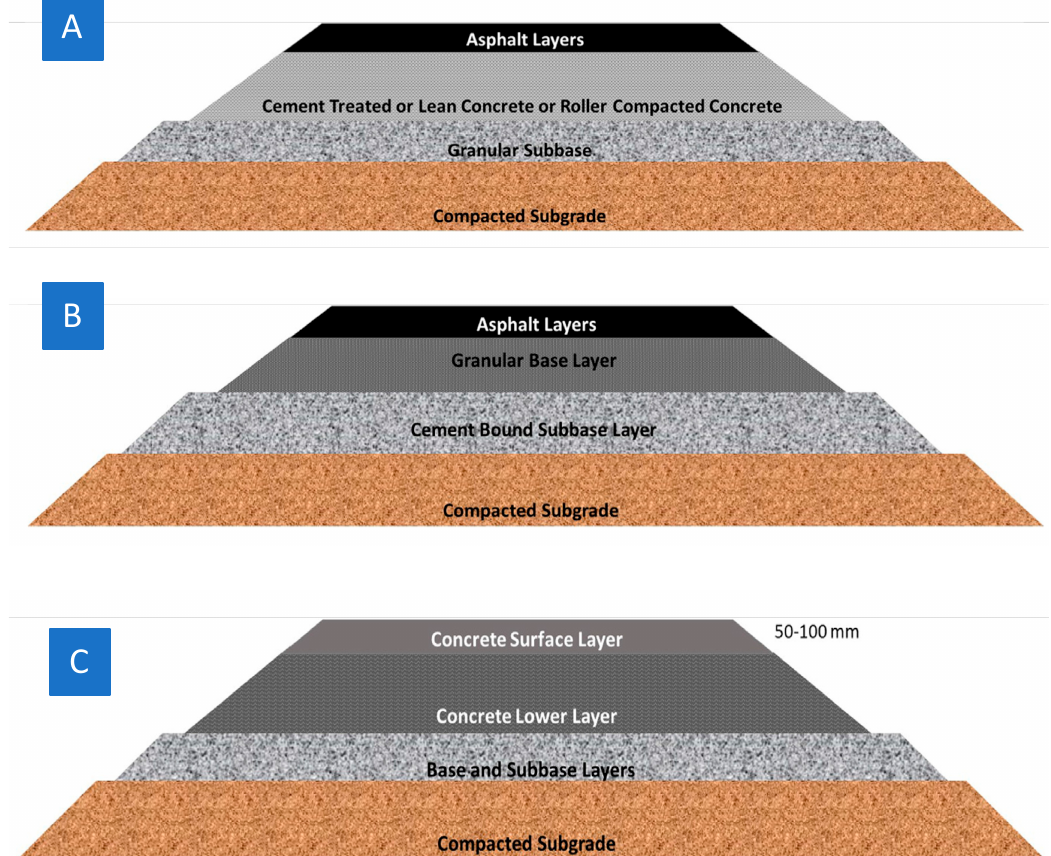
Figure 1. Cross sections of ( A ) a semi- rigid pavement, ( B ) an inverted pavement and ( C ) composite two-lift pavement [21].